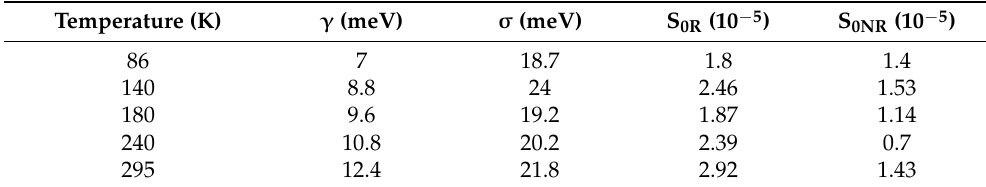
Table 1. Fitting parameters to the 2DES maps shown in Figure 3a according to the model described by Equation (3) ( γ : dephasing rate, σ : inhomogeneous width, S 0R , S 0NR : 2DES rephasing and non rephasing amplitudes).